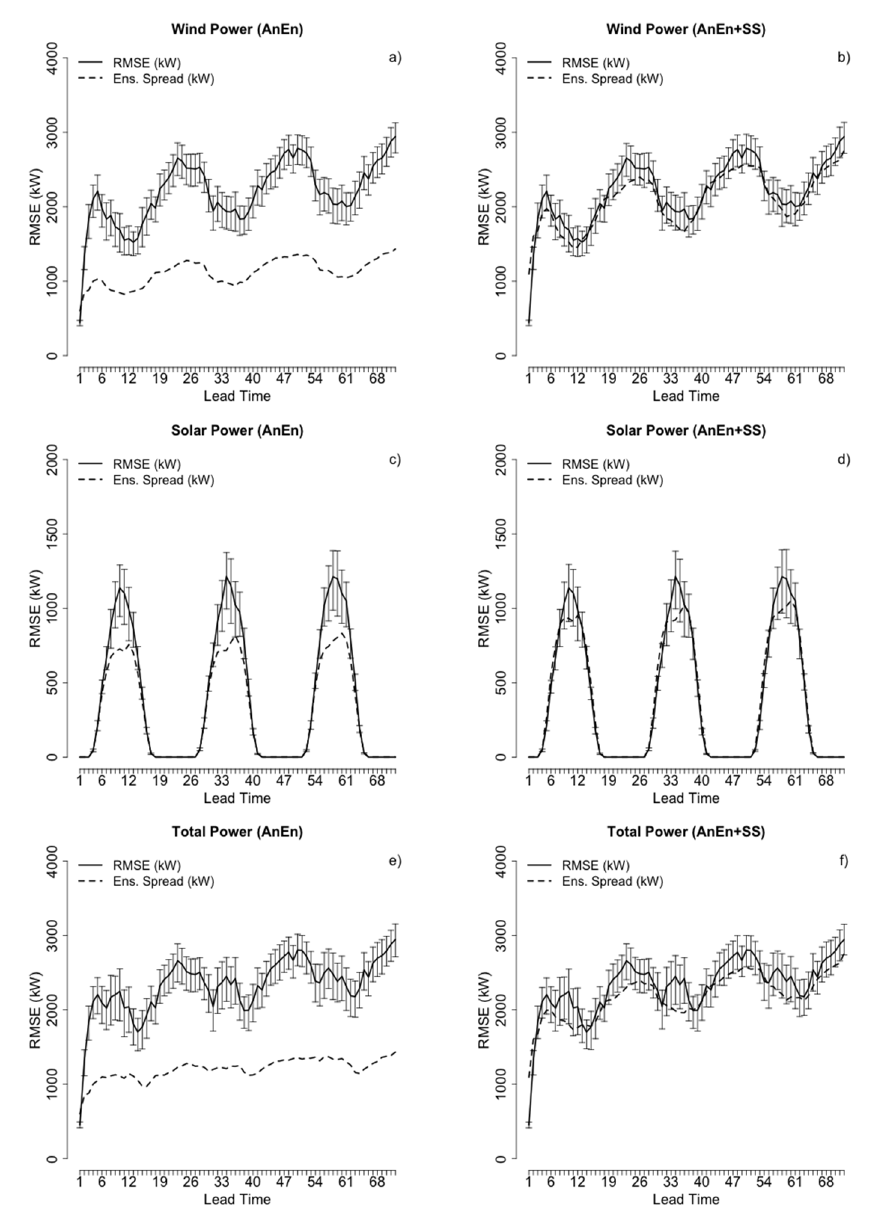
Figure 7. Root mean squared error (solid) and spread (dashed) of the analog ensemble (AnEn), ( a , c , e ) and AnEn + Schaake shuffle (SS), ( b , d , f ) ensemble predictions of total wind power ( a , b ), total solar power ( c , d ), and total wind + solar power ( e , f ).